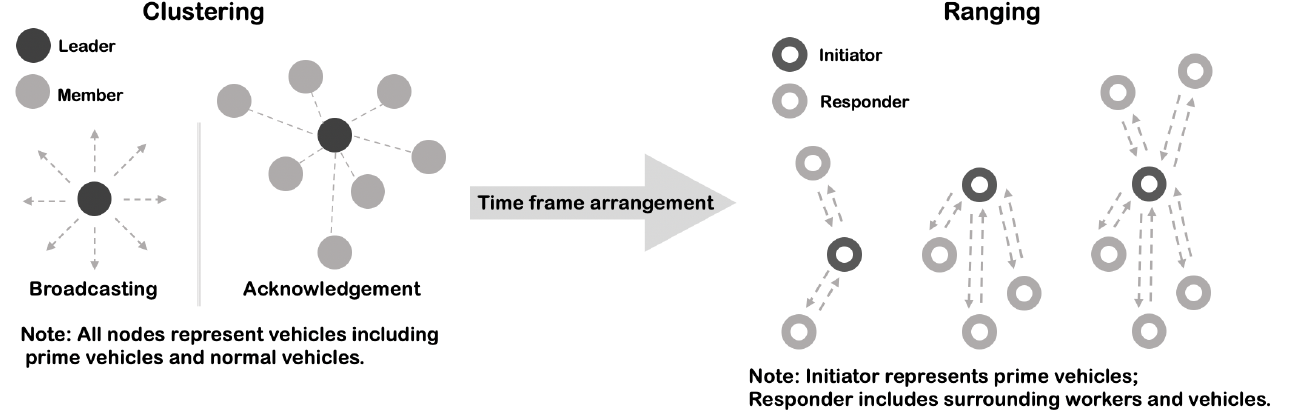
Figure 8. The Workflow of the FTDMA Protocol in the communication